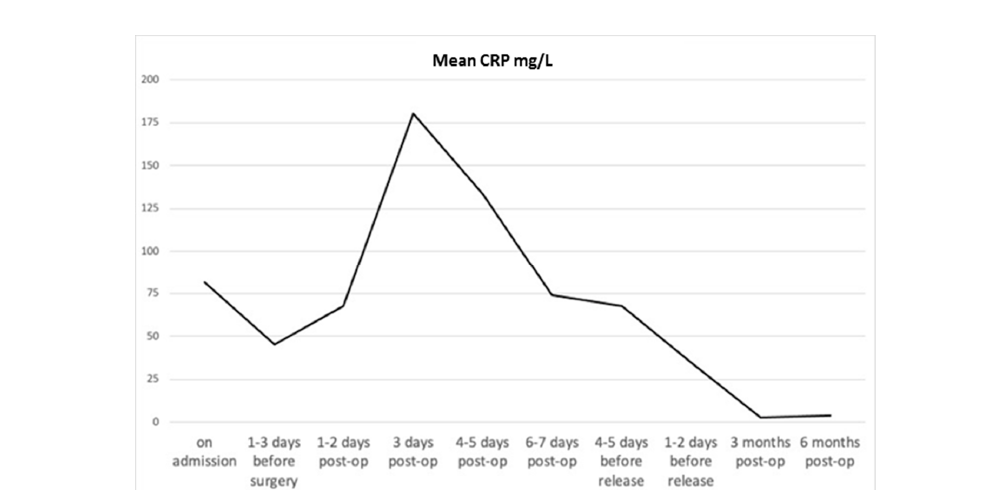
Figure 2. C-reactive protein measured in peripheral blood samples. Concentration was highest shortly after surgery and was within the normal range after 3 months. CRP: C-reactive